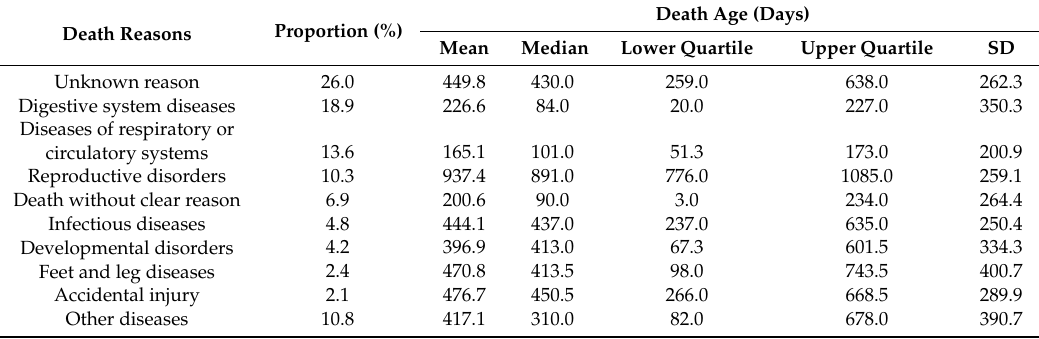
Table 1. The death age (days) of dairy calves and replacement heifers caused by different reason categories.